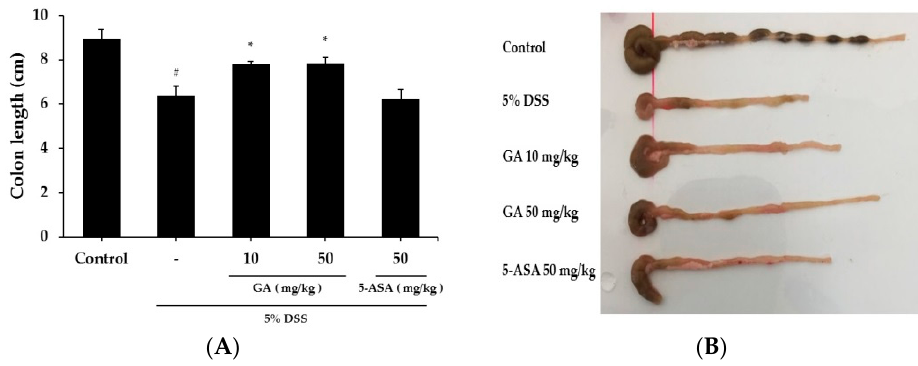
Figure 2. Effects of GA on DSS-induced colon shortening. ( A ) Average colon length in cm measured after 10 days at the time of sacrifice; ( B ) Representative colons of each group. Values represent mean ± S.E.M. ( n = 6). Data were analyzed by Student’s t -test ( # p < 0.05 vs. control and * p < 0.05 vs. DSS alone).